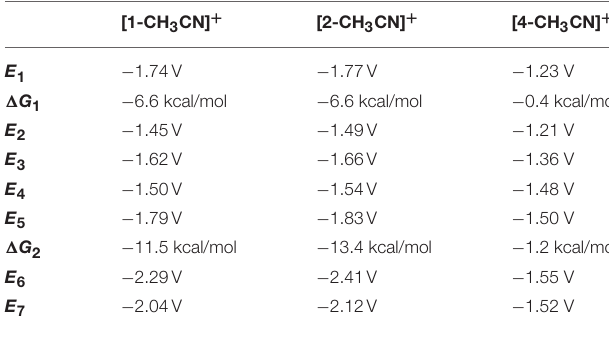
TABLE 5 | Computed reduction potentials (V vs. Fc + / 0 ) and free energy changes ( 1 G , kcal/mol) of catalyst activation and dimerization pathways for Mn I